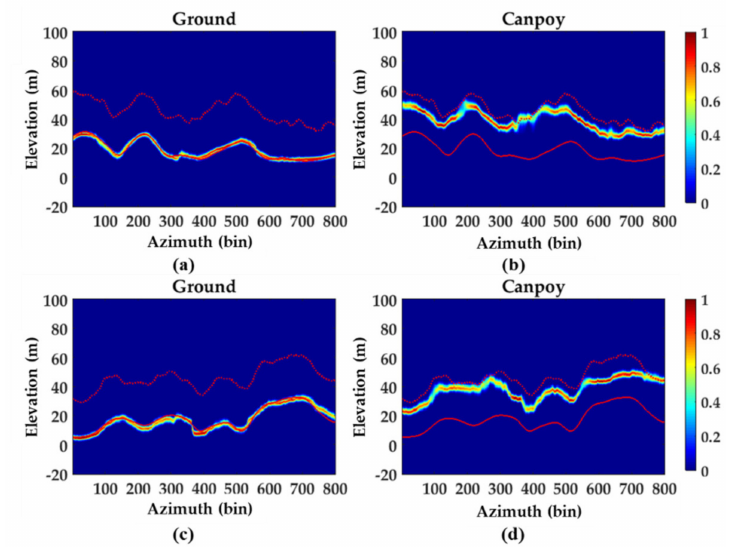
Figure 5. The normalized tomograms of two test lines estimated by the SKP-IMLE method for two different scattering mechanisms: ( a ) ground scattering of test line1; ( b ) canopy scattering of testline1; ( c ) ground scattering of test line2; ( d ) canopy scattering of testline2. The red dotted and solid lines represent DTM+CHM and DTM, respectively.